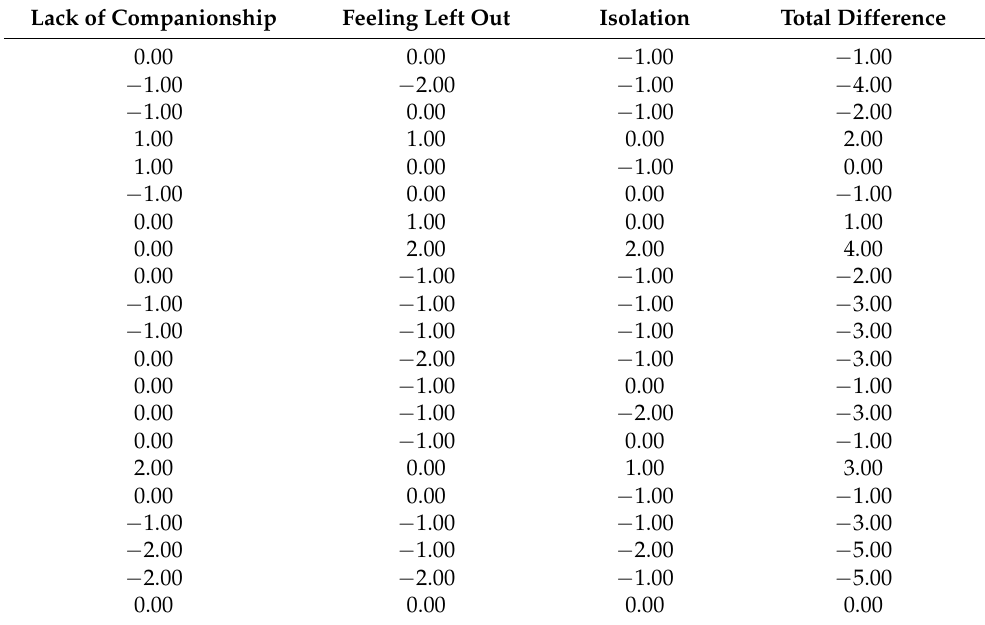
Table 1. Differences in scores on the UCLA loneliness scale upon entry and exit to the service. Lack of Companionship Feeling Left Out Isolation